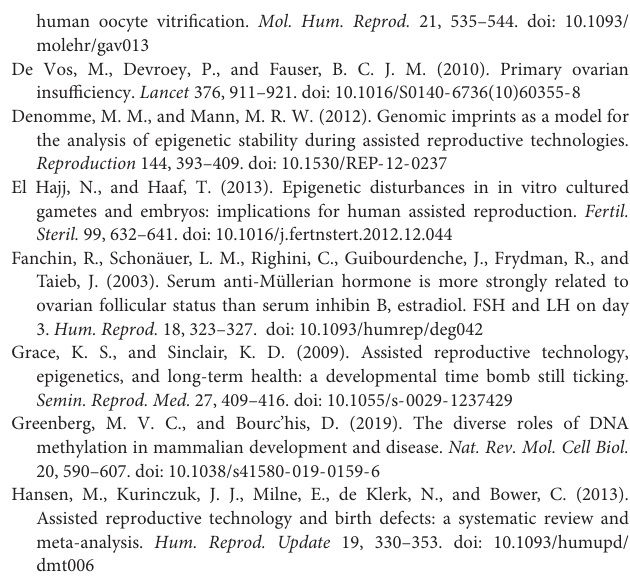
Supplementary Figure 1 | Fragments’ weight between control group and activated group before grafting is approximately the same. Data was applied to paired t test for statistical analysis and presented as the mean ± S N =